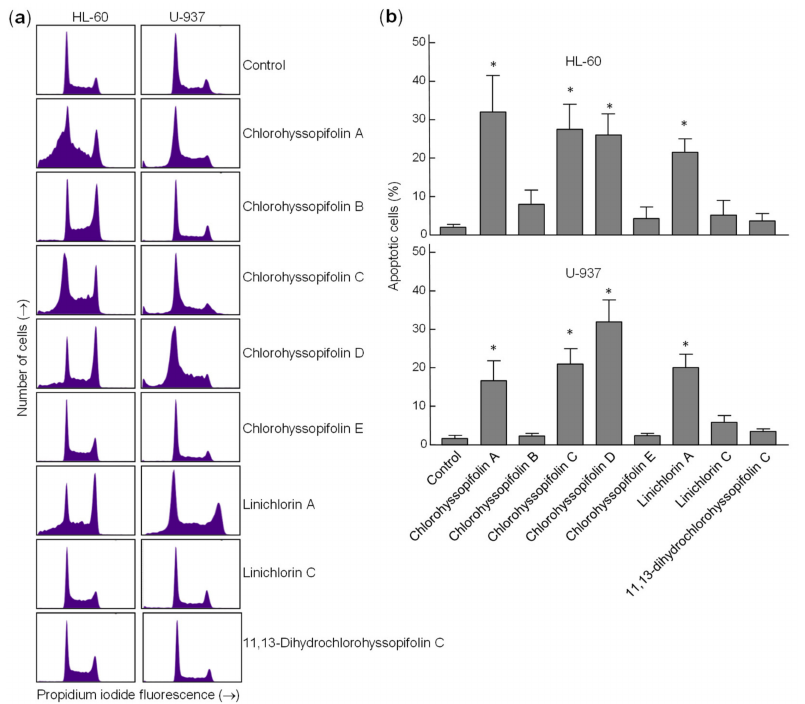
Figure 4. Increase in percentage of apoptotic cells (sub-G 1 fraction) due to guaianolides. ( a ) Representative histogramsofflowcytometryexperimentsafterpropidiumiodidestainingofcellsincubatedinthepresence 10 µ M of the indicated guaianolides for 24 h. ( b ) Cells were treated as above and the percentages of apoptotic cells were determined by flow cytometric analysis after propidium iodide staining. Bars represent means ± S.D. of two independent experiments each performed in triplicate. * p < 0.05, significantly different from untreated control.